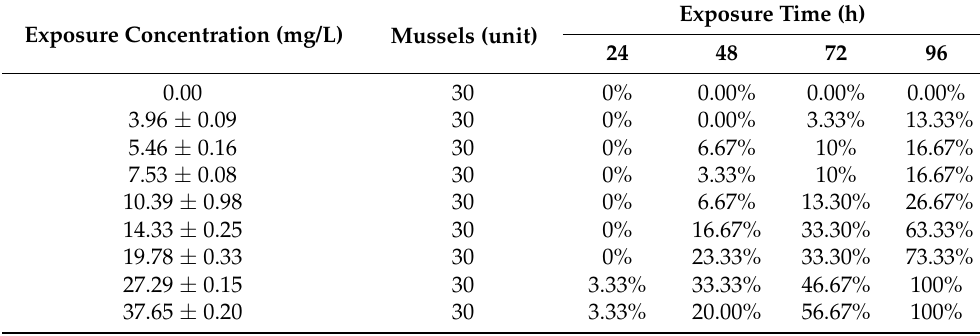
Table 1. The mortality of the acute toxicity test of unionized ammonium in Hyriopsi cumingii . Exposure Concentration (mg/L) Mussels